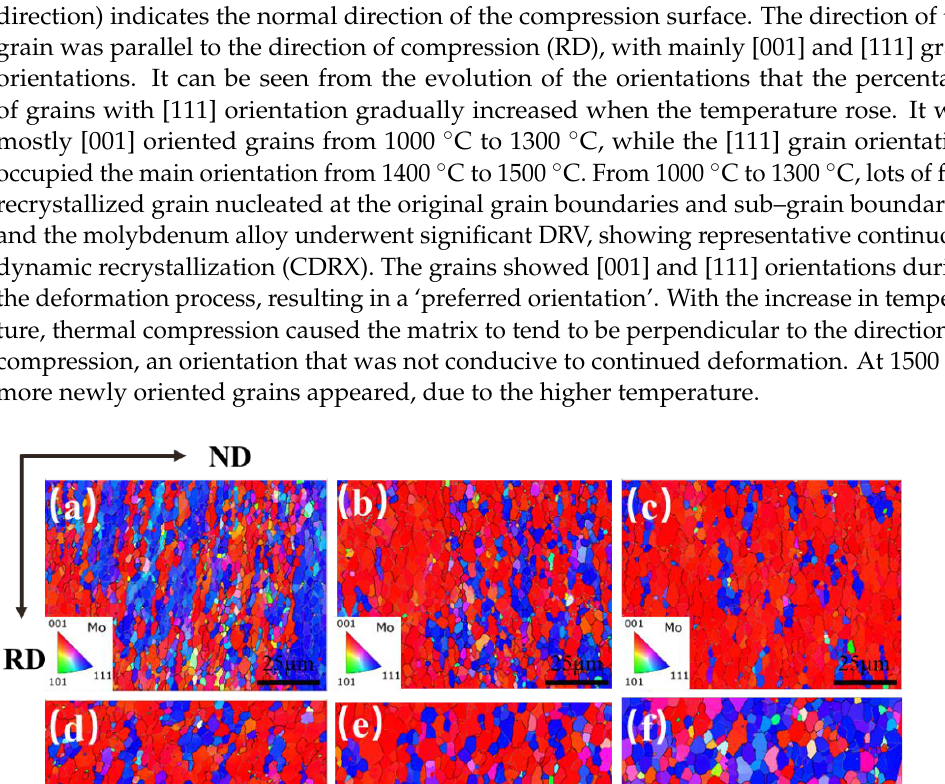
Figure 16. Pole figures of Mo − 1.5wt%Al 2 O 3 molybdenum alloy at strain rate of 0.01 s −1 : ( a ) 1000 °C, ◦ C, ( c ) 1200 ◦ C, ( d ) 1300 ◦ C, ( e ) 1400 ◦ C, ( f ) 1500 ◦ C. ( b ) 1100 °C, ( c ) 1200 °C, ( d ) 1300 °C, ( e ) 1400 °C, ( f ) 1500 °C. ( b ) 1100